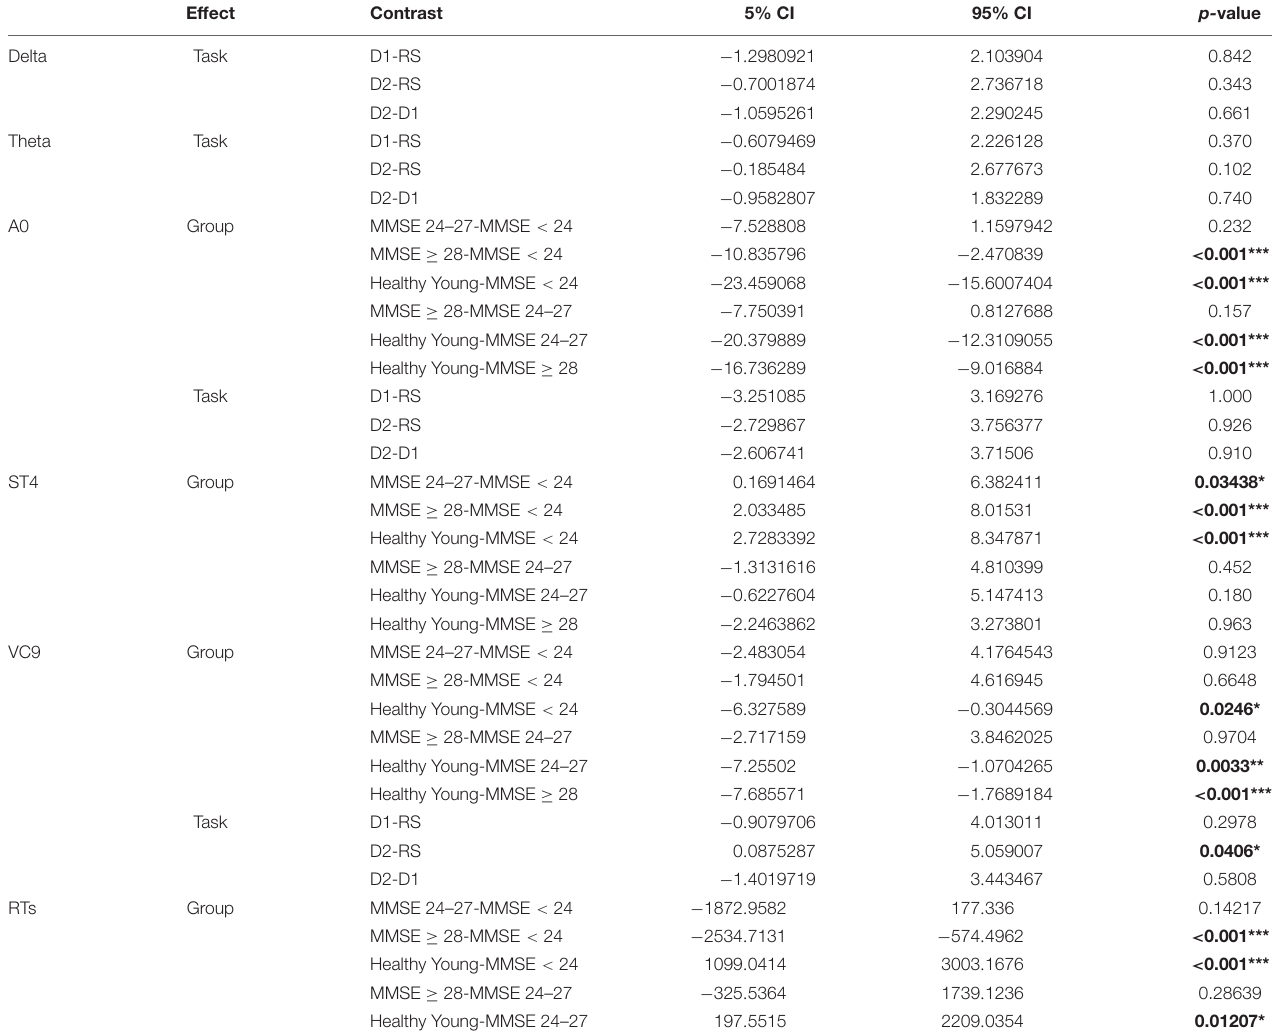
TABLE 6 | Difference, 95% CI, and p -values of the post hoc comparisons for significant main effects of group and task.